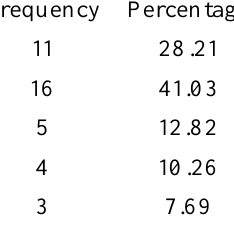
Frequency of Textbooks Prescribed by Teachers for their